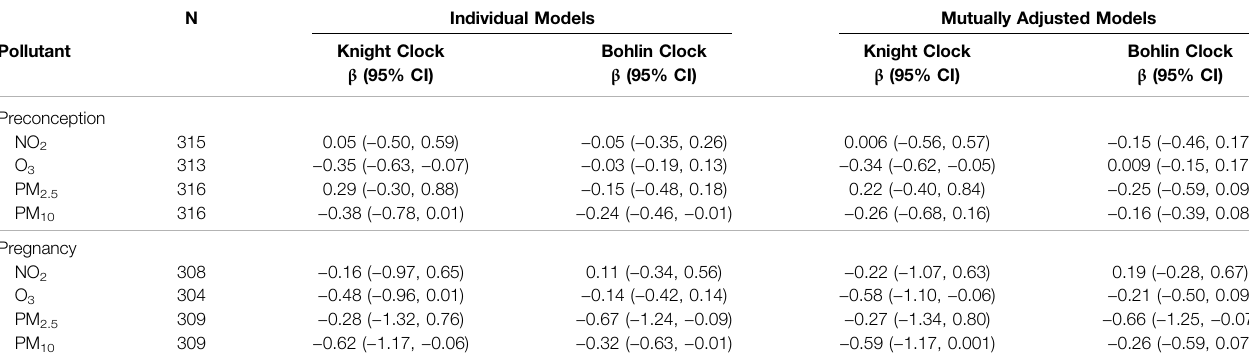
TABLE 2 | Association of pregnancy average ambient air pollution and epigenetic aging at birth in the EARLI and MARBLES cohorts. N Individual Models